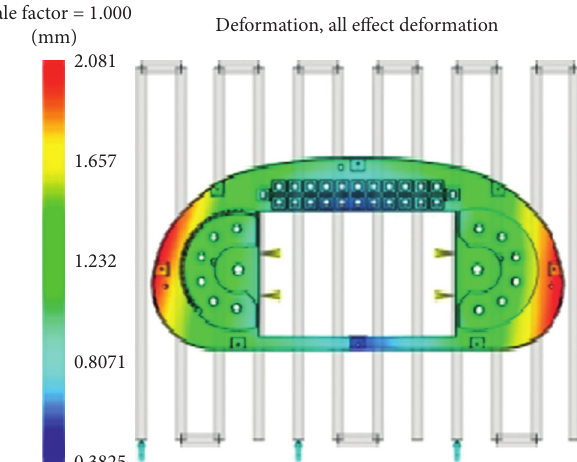
Figure 9: Warpage quantity